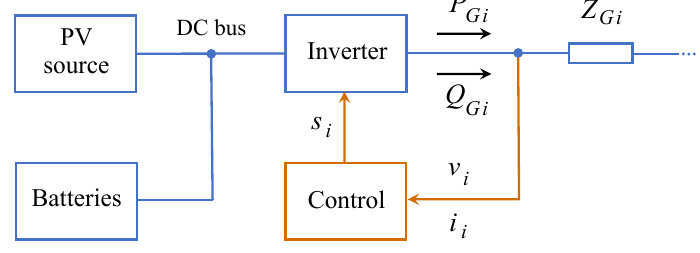
Figure 2. Diagram of the components of the generators.